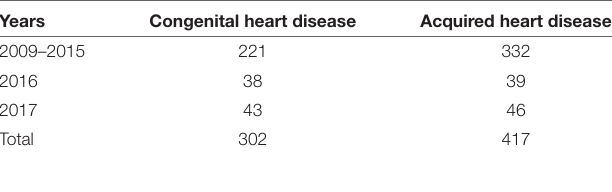
TABLE 4 | Most frequent cardiac operations performed (Internal database, Shisong Cardiac Center, Cameroon). CHD (302)